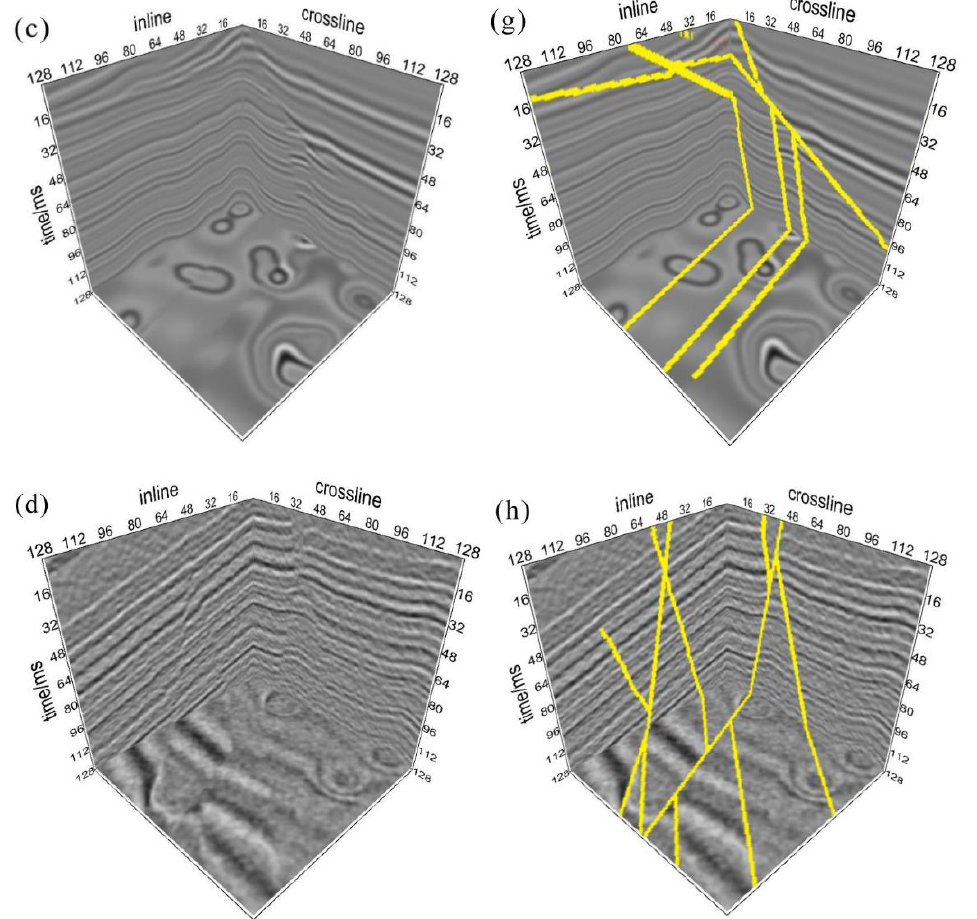
Figure 3. Three-dimensional synthetic seismic data and fault labeling. ( a ) Reverse fault; ( b ) parallel fault; ( c ) conjugate fault; ( d ) normal fault; ( e – h ) are the fault labels of ( a – d ).